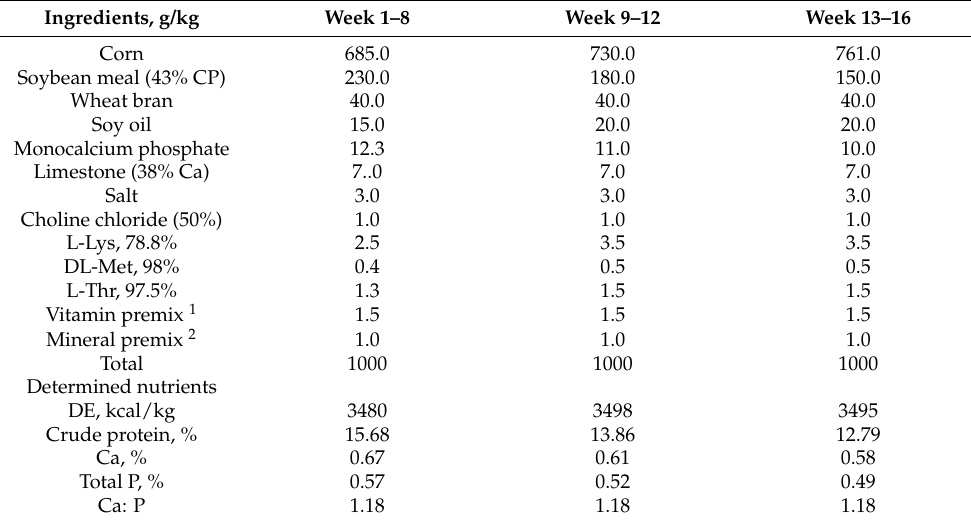
Table 1. Diets’ composition and nutritional